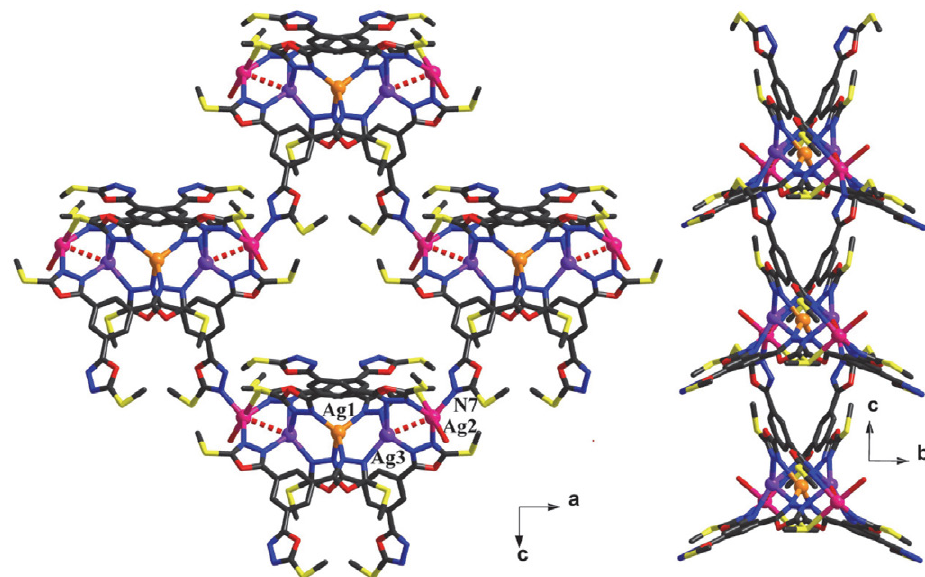
Figure 6. View of 2D network in 2 , front and side views are